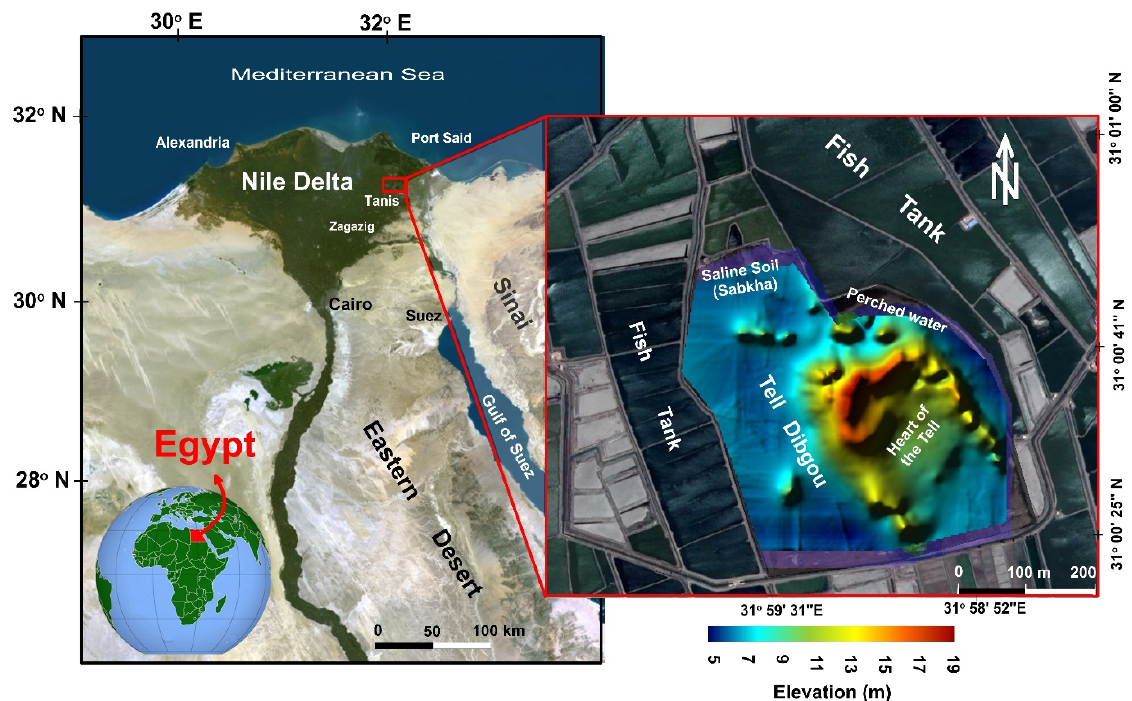
Figure 1. (Left) Google earth image displays the location of the Tell Dibgou archaeological settlement in the Nile Delta; and (Right) zoom-in relief map of the Tell and surrounding agricultural lands and fish tanks.